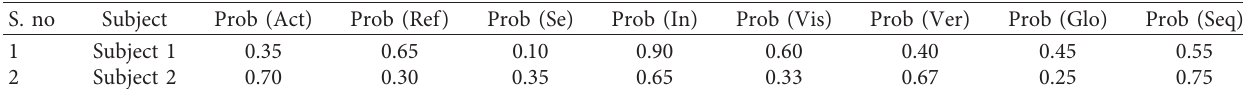
Table 7: Preference values